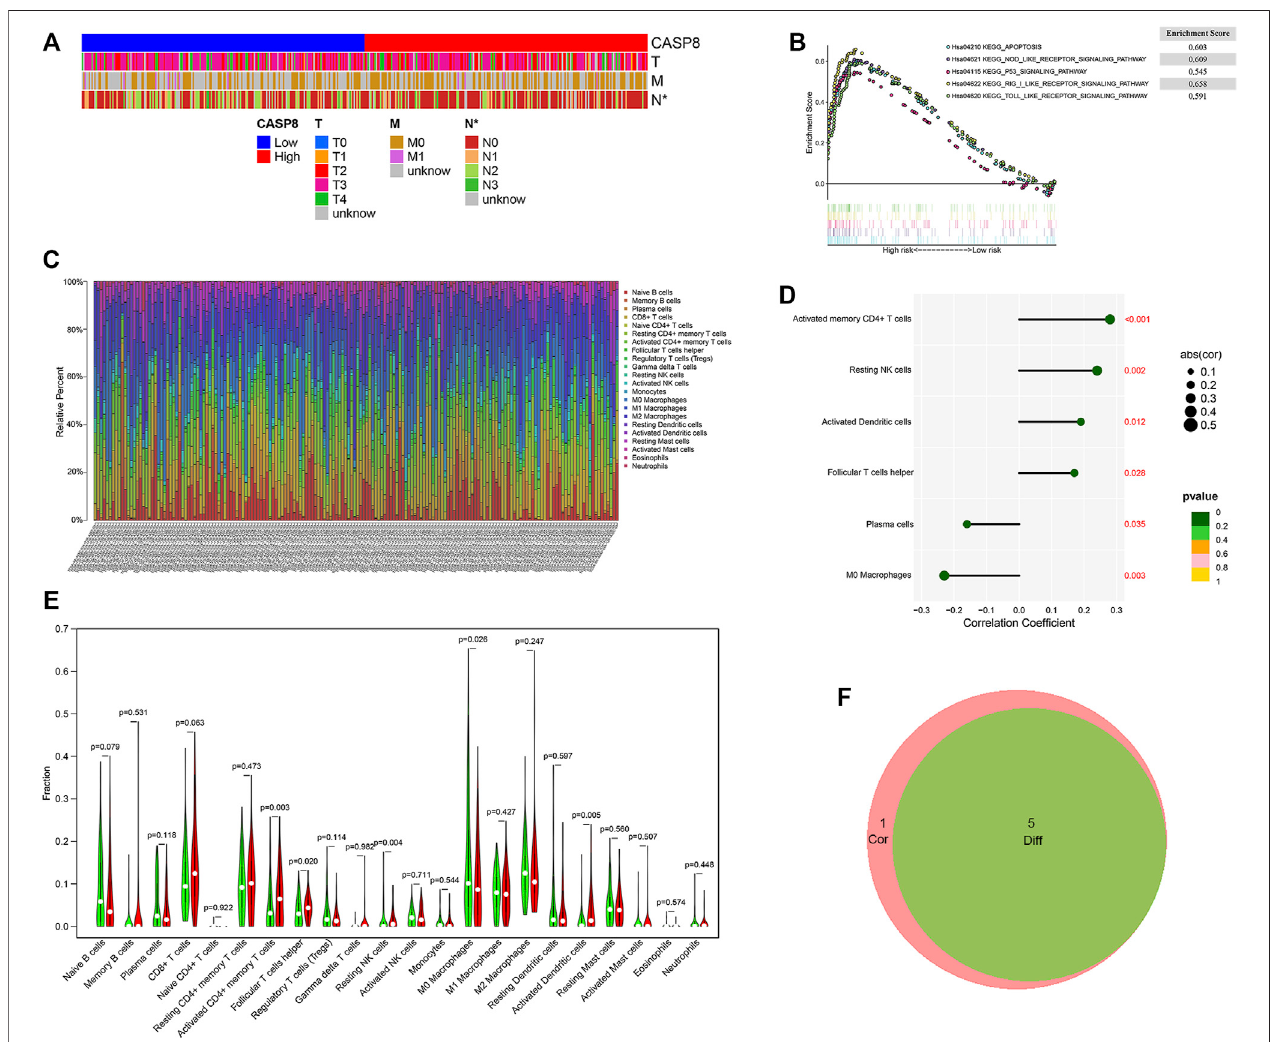
FIGURE6 | GSEA analysisof GSEA8 high expression and its relationship with clinicopathological characteristics and theproportion oftumor in fi ltratingcells (TICs) in bladder urothelial carcinoma (BLCA). (A) The relationship between CASP8 expression and clinicopathological characteristics. (B) The KEGG-enriched gene sets of high CASP8 expression. (C) Barplot displaying the ratios ofthe22 types ofTICs inthe BLCA samples. (D) Lollipop plot showing thesixtypes ofTICs thathad signi fi cant correlations with the CASP8 expression in BLCA samples. (E) Violin plot showing the expression of CASP8 in different TICs. (F) The Venn diagrams showing the intersection immune cells identi fi ed by difference and correlation analyses. *p < 0.05, **p < 0.01, and ***p < 0.001.